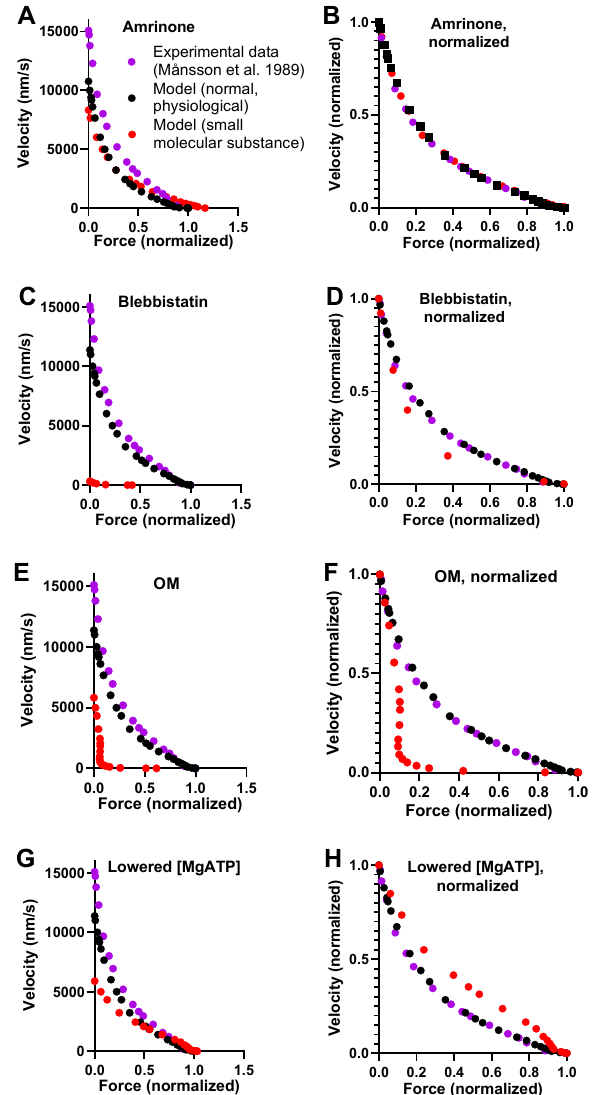
Figure 6. Predictions of the FV relationship with effects of different compounds for the optimized version of the model (Figures 4E and 5; Table 3). ( A ) Simulated data from model under normal physiological conditions (black) and modified (as described in text) to account for the effects of 1–2 mM amrinone (red). The modeled data with amrinone, simulated by assuming a reduction in ∆ G AMDH-AMD from 4 k B T to 1 k B T, are compared to experimental FV data (purple) from [13] in the absence of any myosin-modifying compound. Force given in pN per available cross-bridge (whether attached or not) for model data, whereas the maximum force for experimental data is normalized to exhibit the same maximum force as in the model. ( B ) Data from A replotted after normalizing both force and velocity to maximum value in each solution. ( C ) Simulated data from A, but red symbols correspond to the effects of the saturating concentration of blebbistatin simulated by assuming that this compound reduces k P+ ’ from 3000 s − 1 to 5 s − 1 . ( D ) Data from C replotted after normalizing both force and velocity to maximum value in each solution. ( E ) Simulated data from A, but red symbols correspond to the effects of saturating concentration of OM simulated by assuming that OM reduces ∆ G ∆ G AMDL-AMDH from 12 k B T to 0 k B T and increases PiR from 1 to 6 k B T. ( F ) Data from E replotted after normalizing both force and velocity to maximum value. ( G ) Simulated data from A, but red symbols correspond to effects of reducing [MgATP] from 5 mM to 100 µ M. ( H ) Data from G replotted after normalizing both force and velocity to maximum value in each